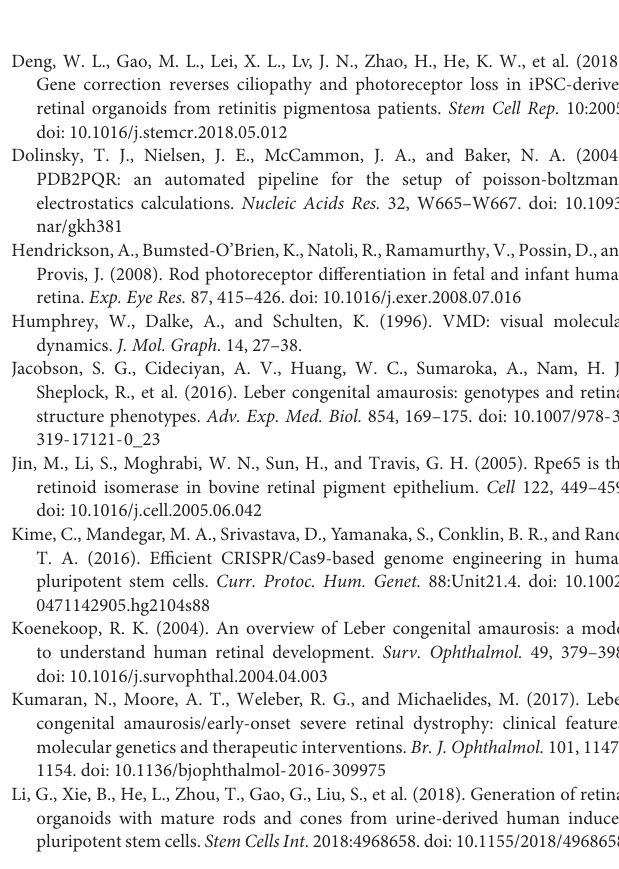
bars, 50 µ m. (D) RT-PCR showed negative expression of exogenous episomal plasmid DNA in five RPE65-hiPSCs lines tested [C11–1 (P7), C4 (P8), C10 (P8), C13 (P9), C14 (P8)]. (E) G-band analysis showed RPE65-hiPSCs (C4) had normal karyotype. FIGURE S4 | Negative controls of immunofluorescence staining (IFS) in Figure 5 . To exclude the false positive caused by the non-specific binding of second antibodies, three types of second antibodies (A–C) used in Figure 5 were tested with PBS instead of the first antibodies, Recoverin raised from rabbit (A) , Rhodopsin from mouse (B) , and S opsin from rabbit (C) as the negative controls. IFS were performed parallelly on serial sections of retinal organoids older than W20. All images were taken under the same exposure conditions with an LSM 510 confocal microscope (Zeiss). The detailed information of all antibodies can be found in Table 1 . Scale bars, 20 µ m. FIGURE S5 | Propagation of RPE65-hiPSCs derived RPE cells. (A) Cobblestone-like RPE cells derived from RPE65-hiPSCs contained pigmentation 40 days after differentiation. Scale bar, 200 µ m. (B) Passaged RPE cells on D2. Scale bar, 200 µ m. (C) Passaged RPE cells presented cobblestone morphology and regained pigmentation 4 weeks after passage. Scale bar, 50 µ m. (D) Immunostaining showed that the typical RPE markers PAX6, OTX2, MITF, and ZO-1 were positive in passaged RPE cells derived from both control and RPE65 hiPSCs. Scale bars, 20 µ m. FIGURE S6 | Functional evaluation of patient RPE cells. (A,B) Z-stack confocal images showing the phagocytosed CM-Dil labeled POS (red) by RPE cells derived from control (A) and patient (B) hiPSCs. During 12 h POS incubation, cells cultured in 4 ◦ C were used as negative control. (C) The POS phagocytosis capacity of RPE65-hiPSCs derived RPE cells was comparable to the control. Mean ± SD , n = 3. (D) The total VEGF secretion of both control- and patient-derived RPE cells cultured for 24 h was equivalent. Mean ± SD , n =